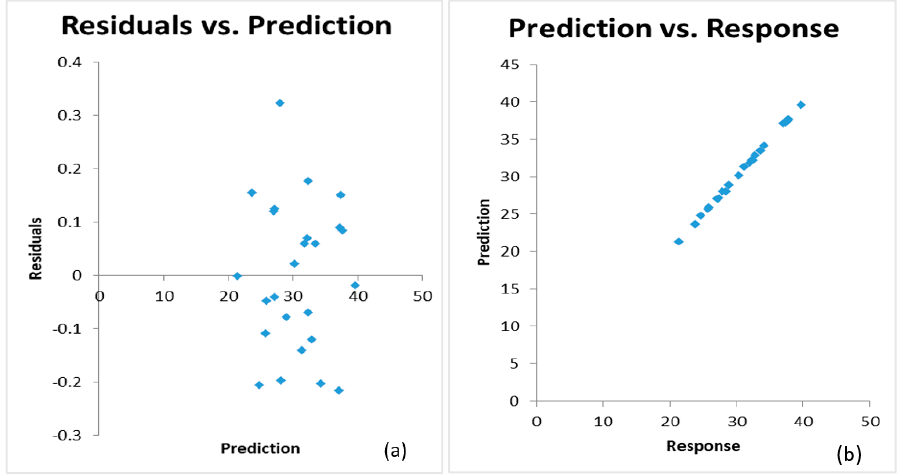
Figure 7. ( a ) Residual vs. prediction; ( b ) prediction vs. response plot.